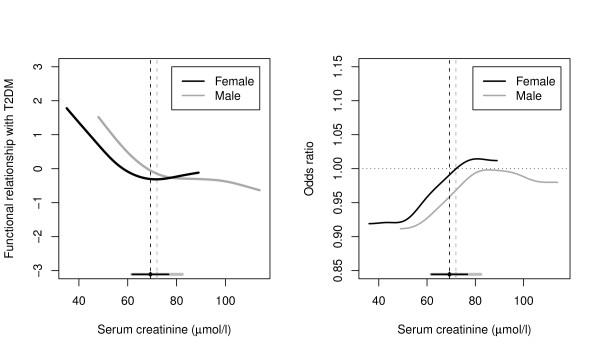
Relationship between serum creatinine and type 2 diabetes. Left: Estimated functional relationship between serum creatinine and T2DM using Generalized Additive Models (GAM). Breakpoints and 95% CIs from a piecewise linear models at the bottom. Right: Corresponding odds ratios (approximately 0.90 below and 1.0 above the breakpoints). Given the large uncertainty in the location of the breakpoints the graph does not take the shape of the idealized step function a piecewise linear model assumes, but has a marked transition face.